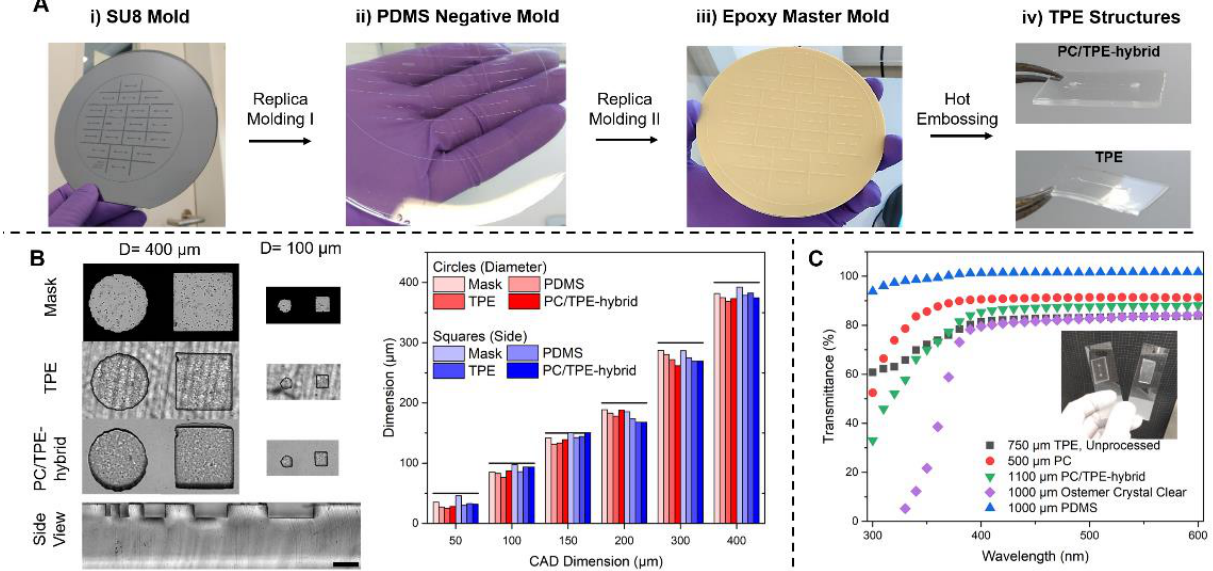
Figure 1. ( A ) TPE microfabrication process: (i) A silicon wafer with SU-8 patterns serves as a master for (ii) the negative PDMS mold, which is replicated once more in the form of (iii) the epoxy master mold. Hot embossing using the epoxy mold enables fabrication of (iv) TPE and PC/TPE-hybrid-based microfluidic platforms. ( B ) Micrographs of features fabricated by hot embossing into TPE and PC/TPE-hybrid as well as the used photomask. A close-up side view shows microstructures in the TPE part of a PC/TPE-hybrid. The full-sized side view image of the PC/TPE-hybrid, additionally showing the transition from TPE to PC, is presented in the supplementary information. Scale bar represents 200 µ m. Comparison of feature dimensions between different structures, materials, and the original CAD design. The features have a height of approximately 100 µ m. ( C ) UV-VIS transmittance spectra of TPE, PC, and PC/TPE-hybrid as well as of an Ostemer Crystal clear disc and a PDMS slab for comparison purposes. The inset comprises a photograph of a PC/TPE-hybrid device (left) and a TPE device (right) demonstrating the difference in transpar- ency.